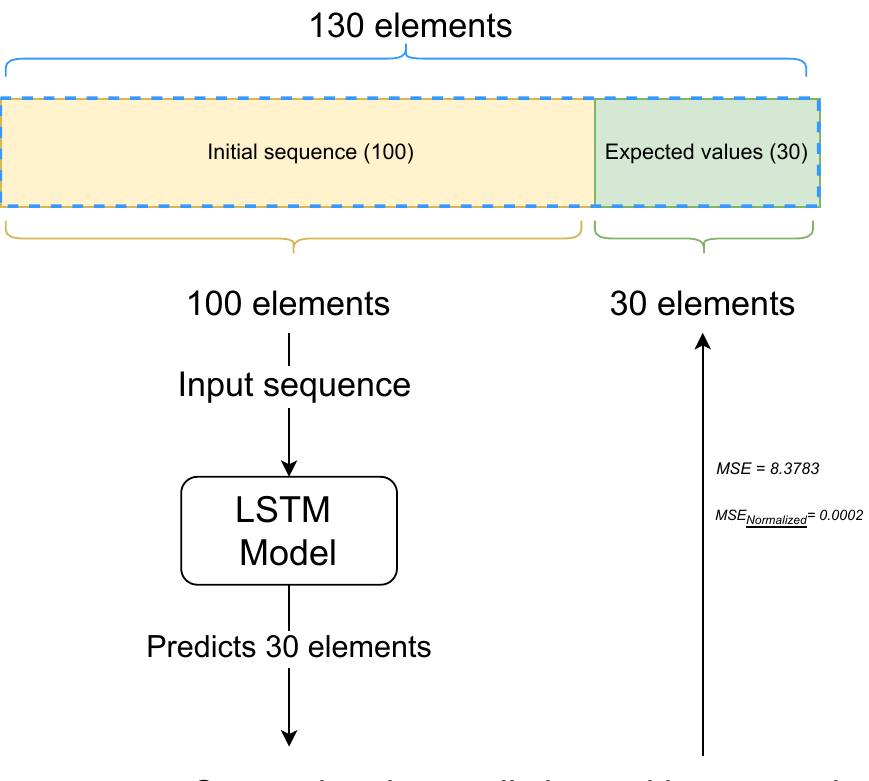
Figure 14. Logic behind the model’s validation